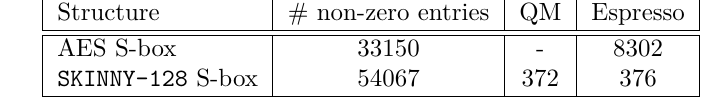
Table 3: Number of constraints to represent ∗ -DDTs of AES and SKINNY-128